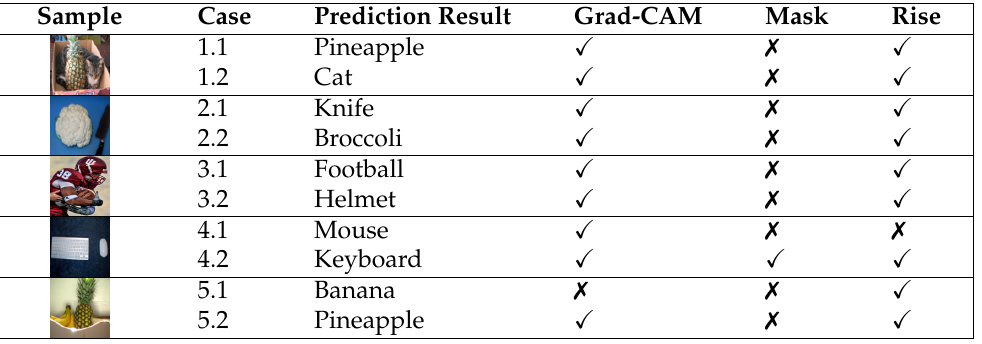
Table 4. Comparisons of class discrimination of three different explanation methods. The first column is the five test examples of the DataT. The second column is the prediction result of the pre-trained VGG-16 model. The last three columns are the class discrimination results of the explanation methods. ( (cid:88) mark indicates that the class-discriminativeness characteristic is satisfied).